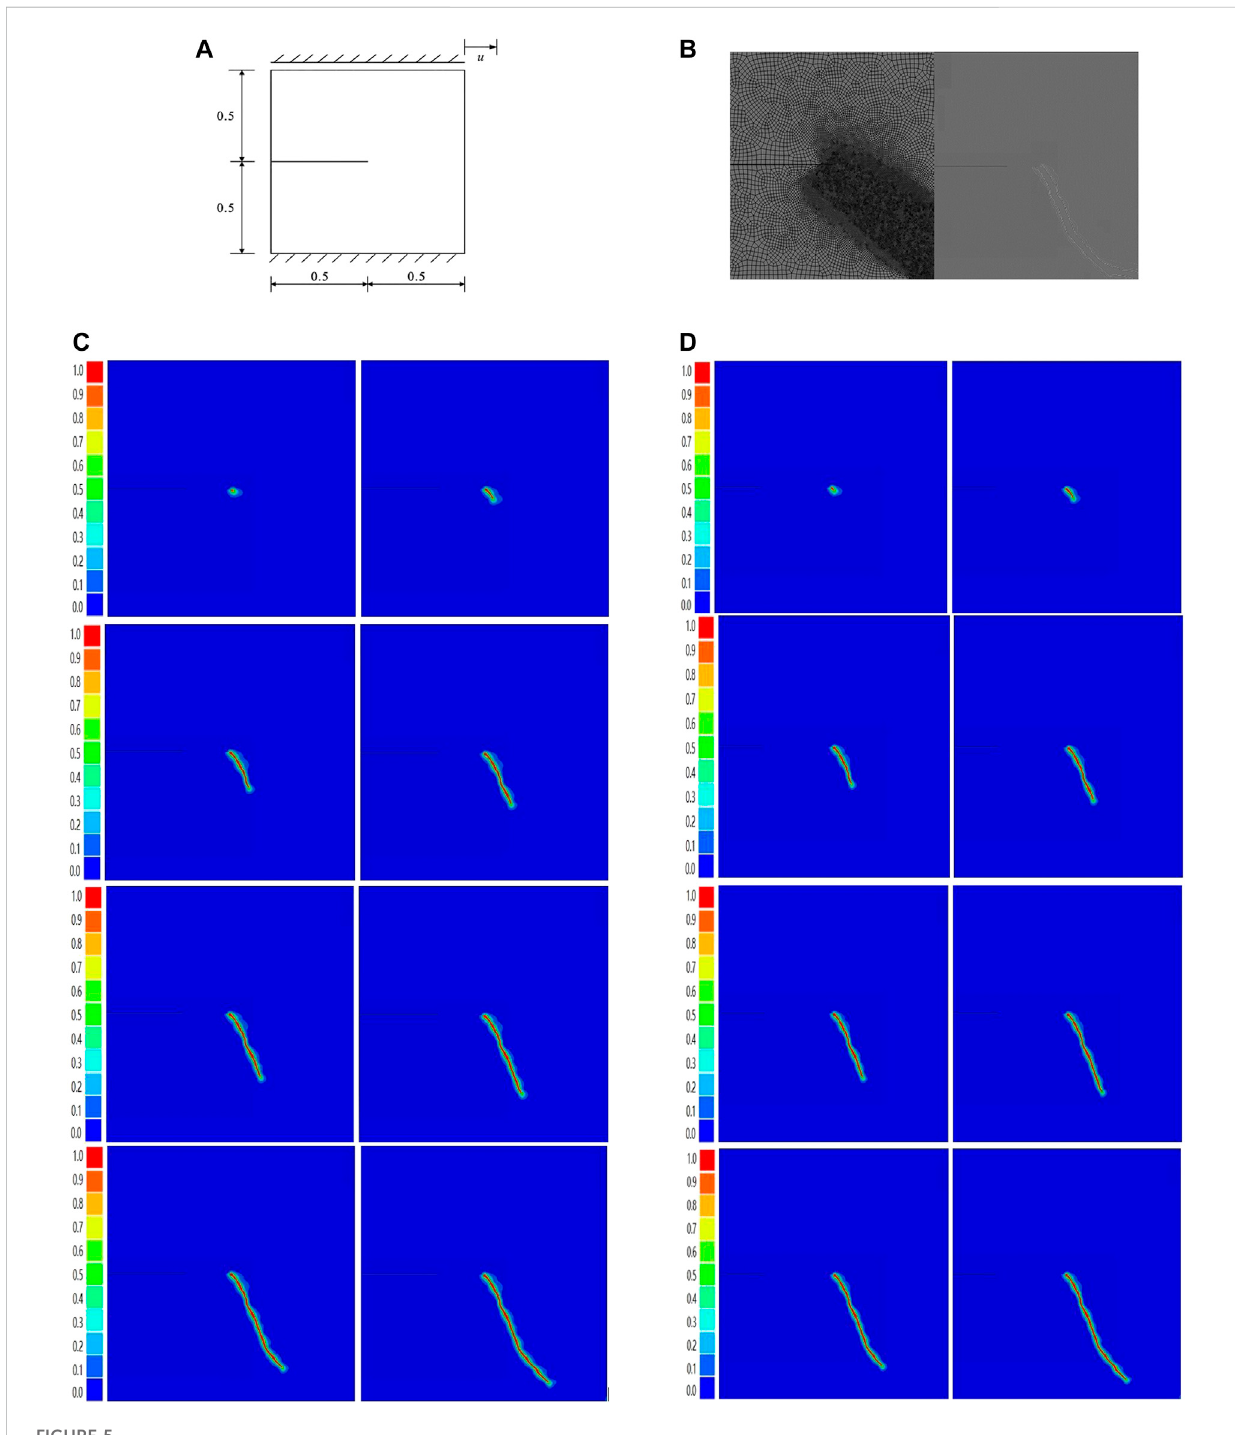
path (traditional